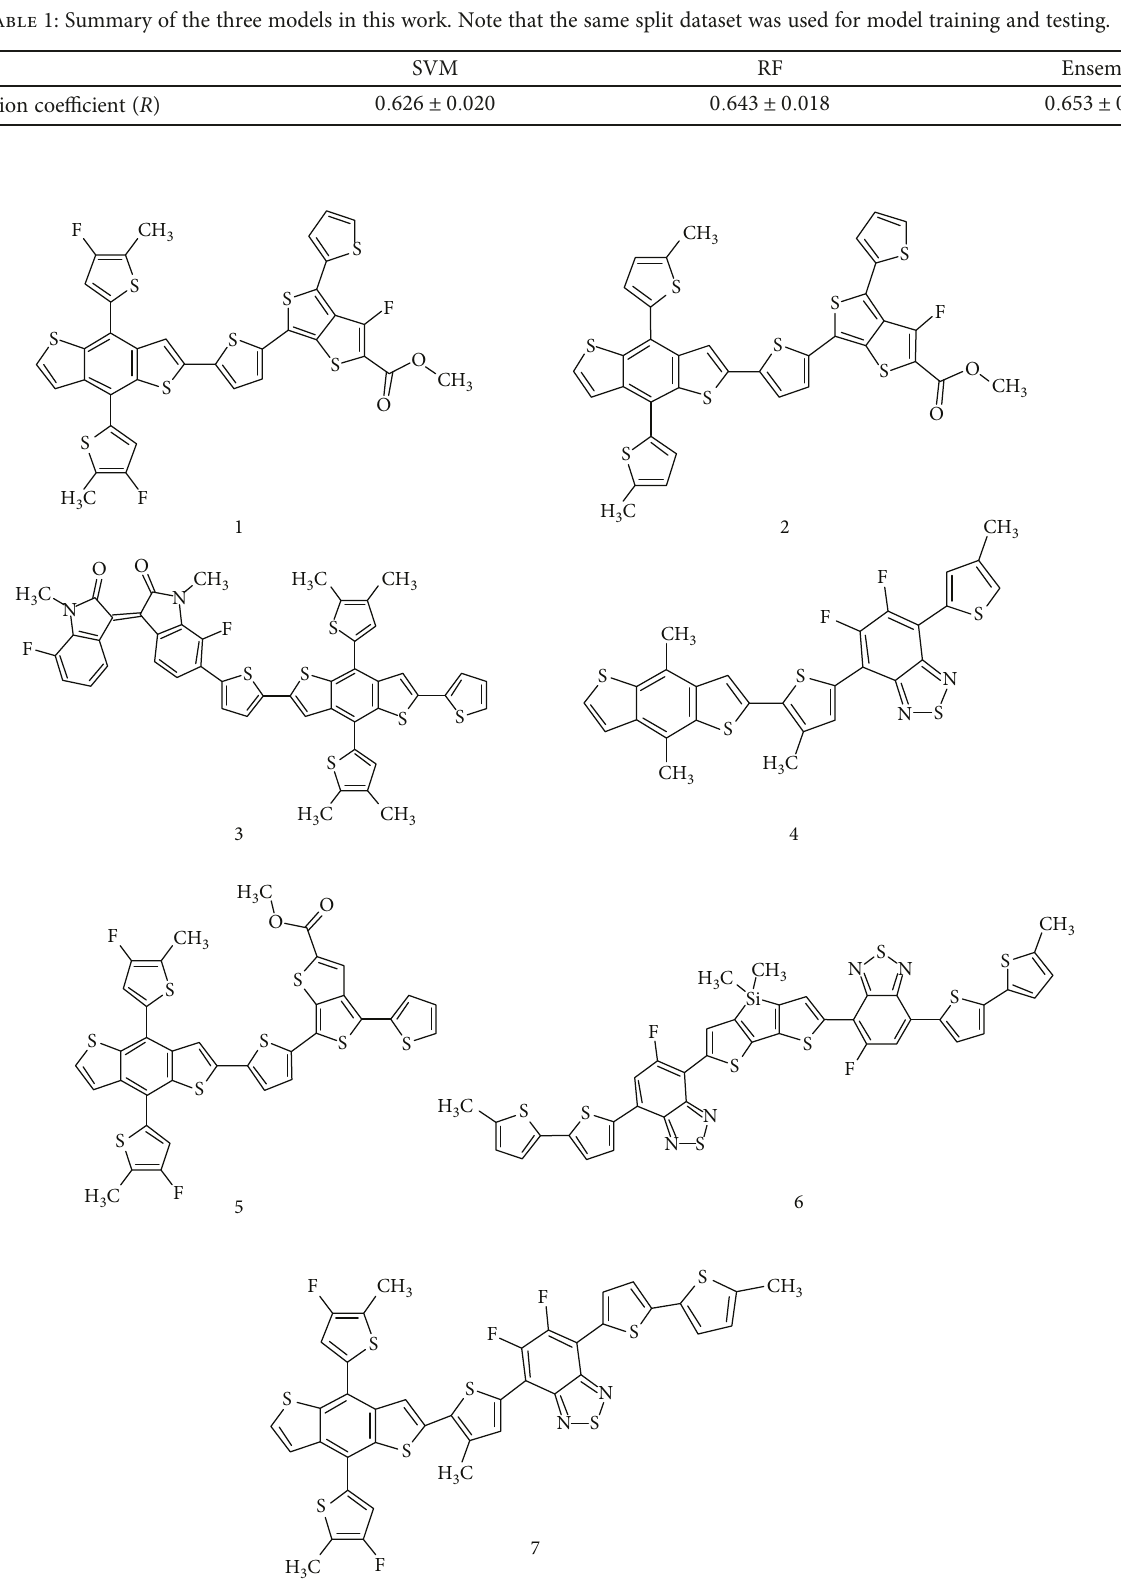
Figure 5: The chemical structures (1-6) of the repeating units that we predicted from the other dataset consisting of 316 compounds. Structure 7 is the one that we proposed; it was predicted to have the highest PCE value among the seven compounds in this fi